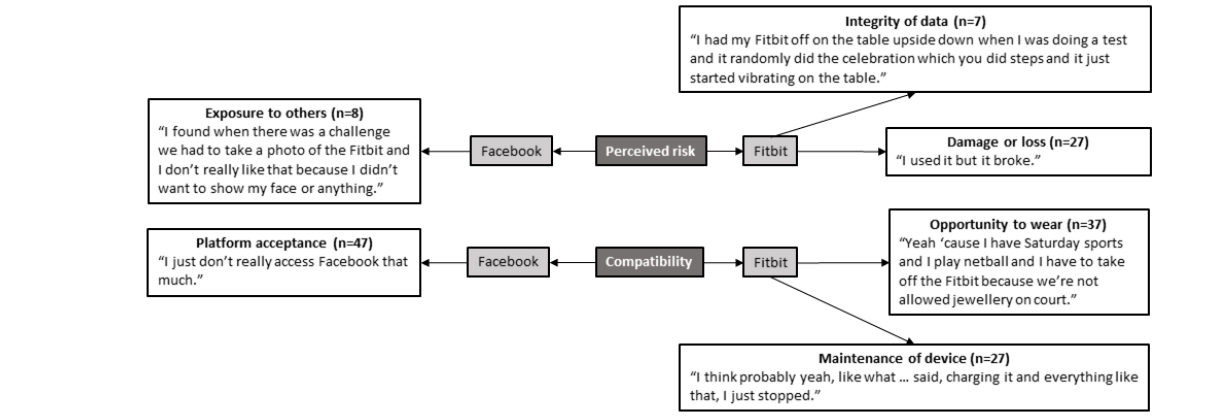
Figure 7. Facebook and Fitbit perceived risk and